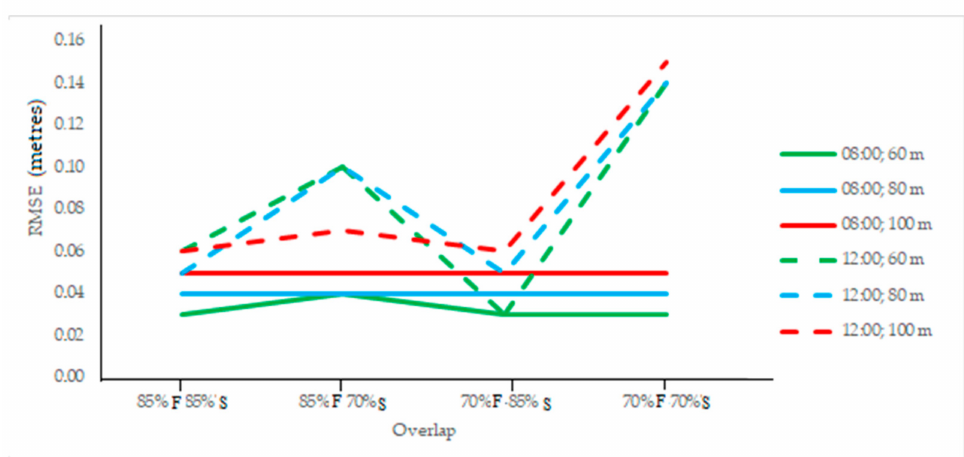
Figure 9. RMSE vs. different side (S) and forward (F) overlap for different flight heights and flight times (dashed lines are used for noon flights while solid lines are for 8 a.m. flights). Note that the number of GCPs is not a variable because only experiments performed with 10 GCPs were